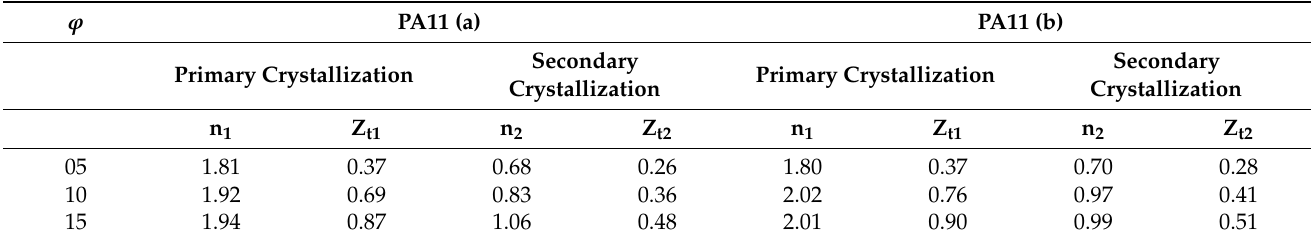
Table 2. Avrami constants for all samples at various cooling